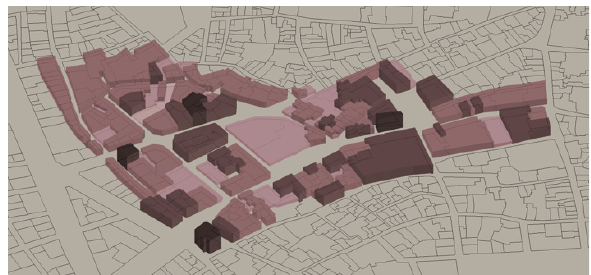
Figure 6. Example of the plot surface analysis of a study area (The authors,